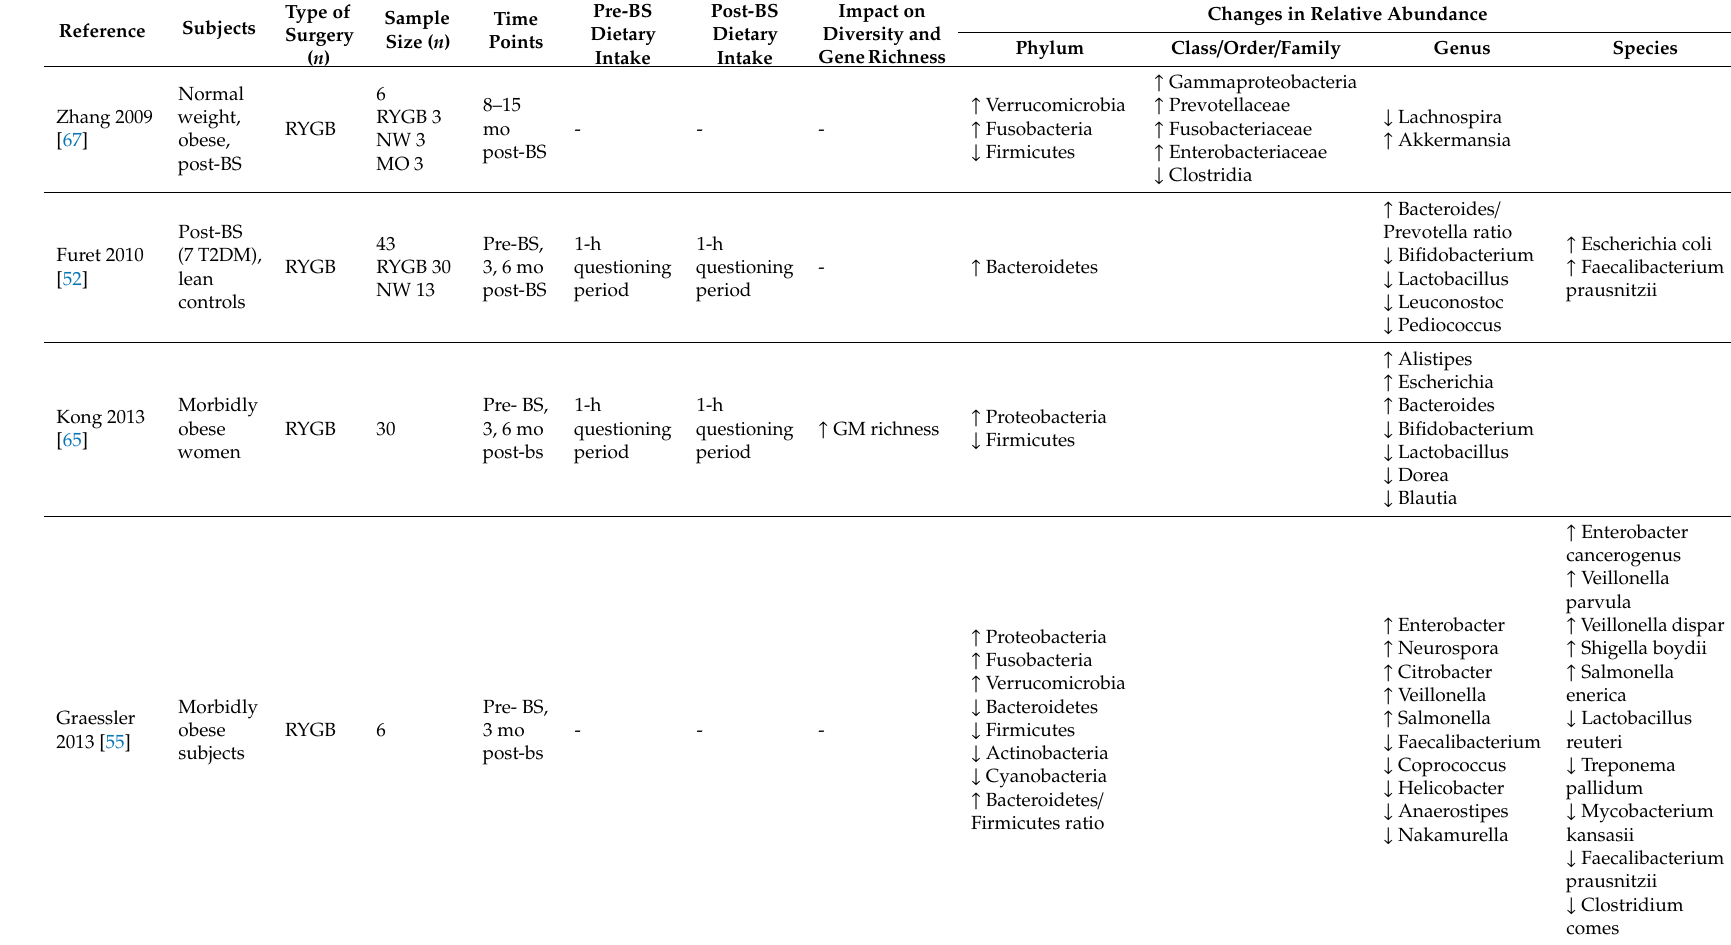
Table 1. Changes in the gut microbiota following bariatric surgery in